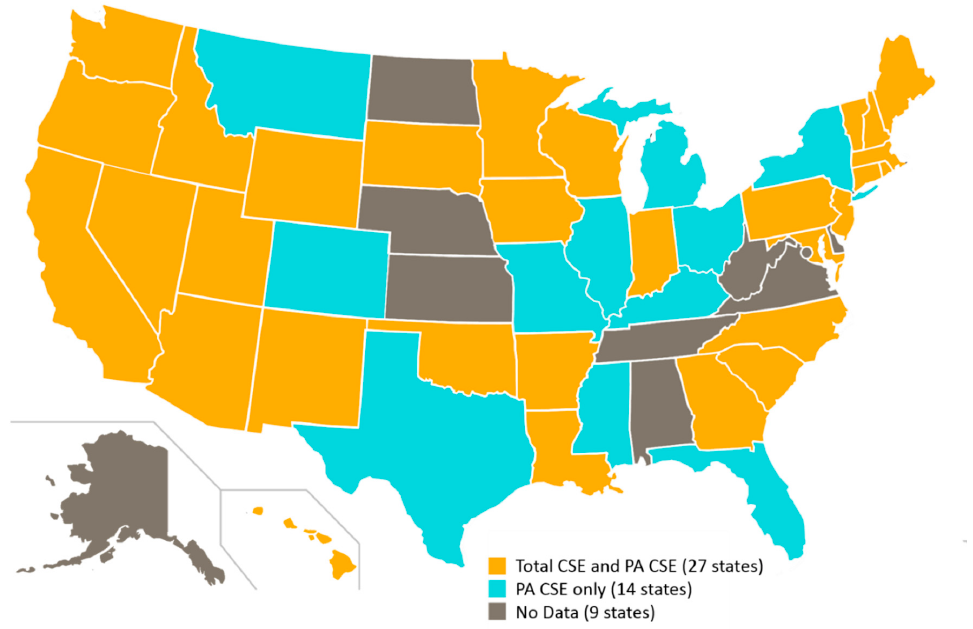
Figure 1. States in the Lawrence Berkeley National Laboratory (LBNL) Cost of Saving Electricity Database. PA CSE: Program administrator cost of saved electricity.